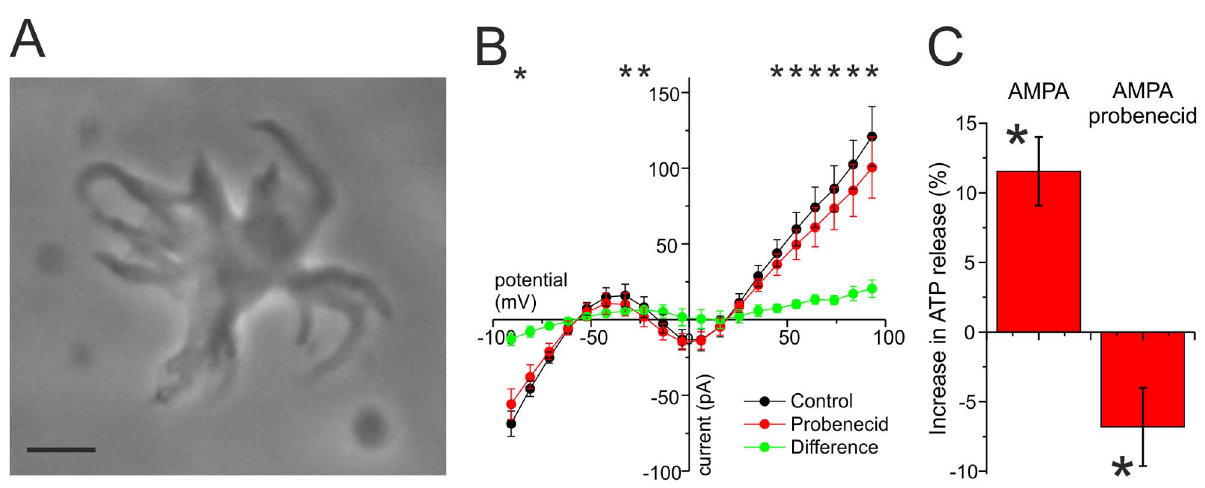
Figure 3. HCs release ATP. (A) Dissociated goldfish HC. This preparation consisted of about 90% of HCs. The remaining material was mostly debris. Scale bar, 20 m m. (B) The mean 6 sem whole-cell IV relations of six dissociated HCs in conditions where potassium currents were inhibited by Cs. Application of 500 m M probenecid (red trace) reduces the conductance of the HCs. The green trace is the IV relation of the probenecid blocked current. This current has similar characteristics as the Panx1 current described by Prochnow et al. [11]. (C) Change in ATP release as measured with the luminescence assay. Depolarization of dissociated HCs by AMPA led to an increase in ATP release, whereas inhibition with probenecid decreased the release significantly. In probenecid, the ATP release was significantly lower than baseline, indicating that HCs in control conditions release ATP.